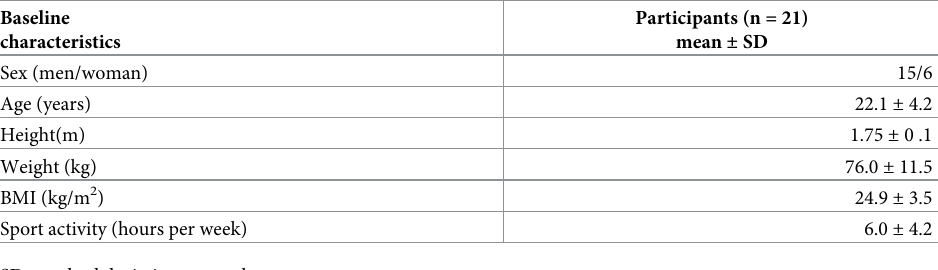
Table 1. Baseline